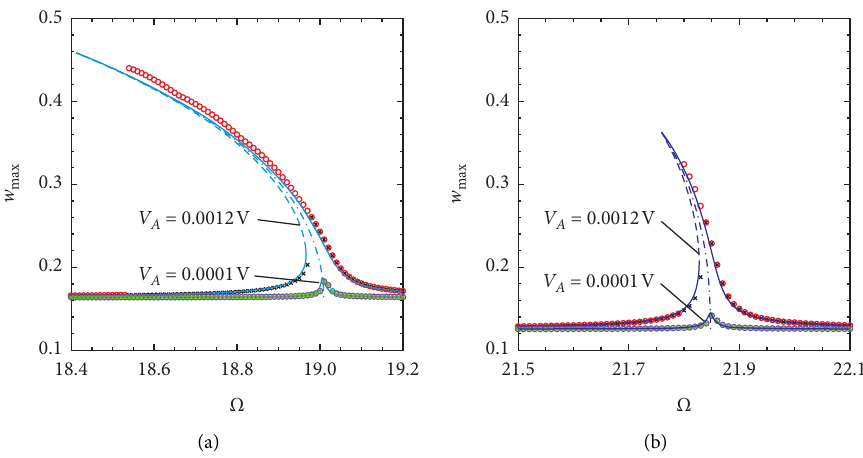
Figure 15: Amplitude-frequency curve: V